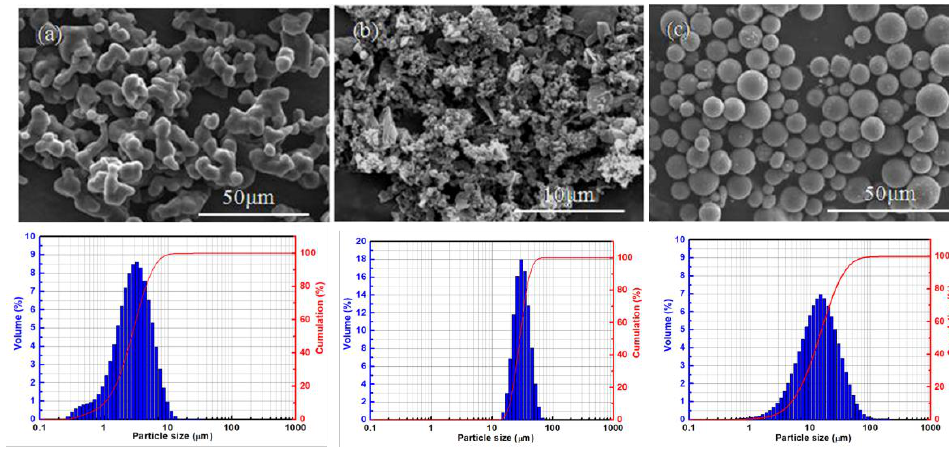
Figure 1. FESEM images of ( a ) B1, ( b ) B2, and ( c ) Mg raw powders. The 01-HD vertical ball mill was used. B powder was weight-blended with 10